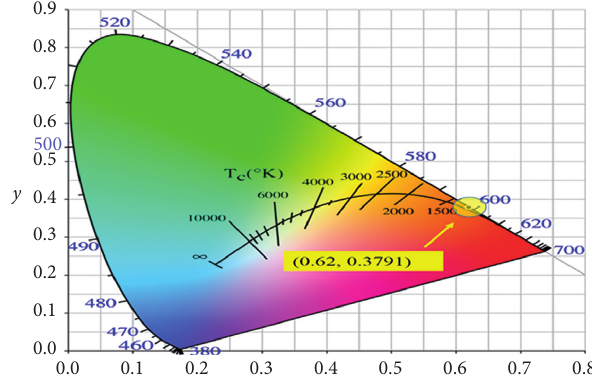
Figure 3: The excitation spectra of (1 at%) SrGd phosphor.